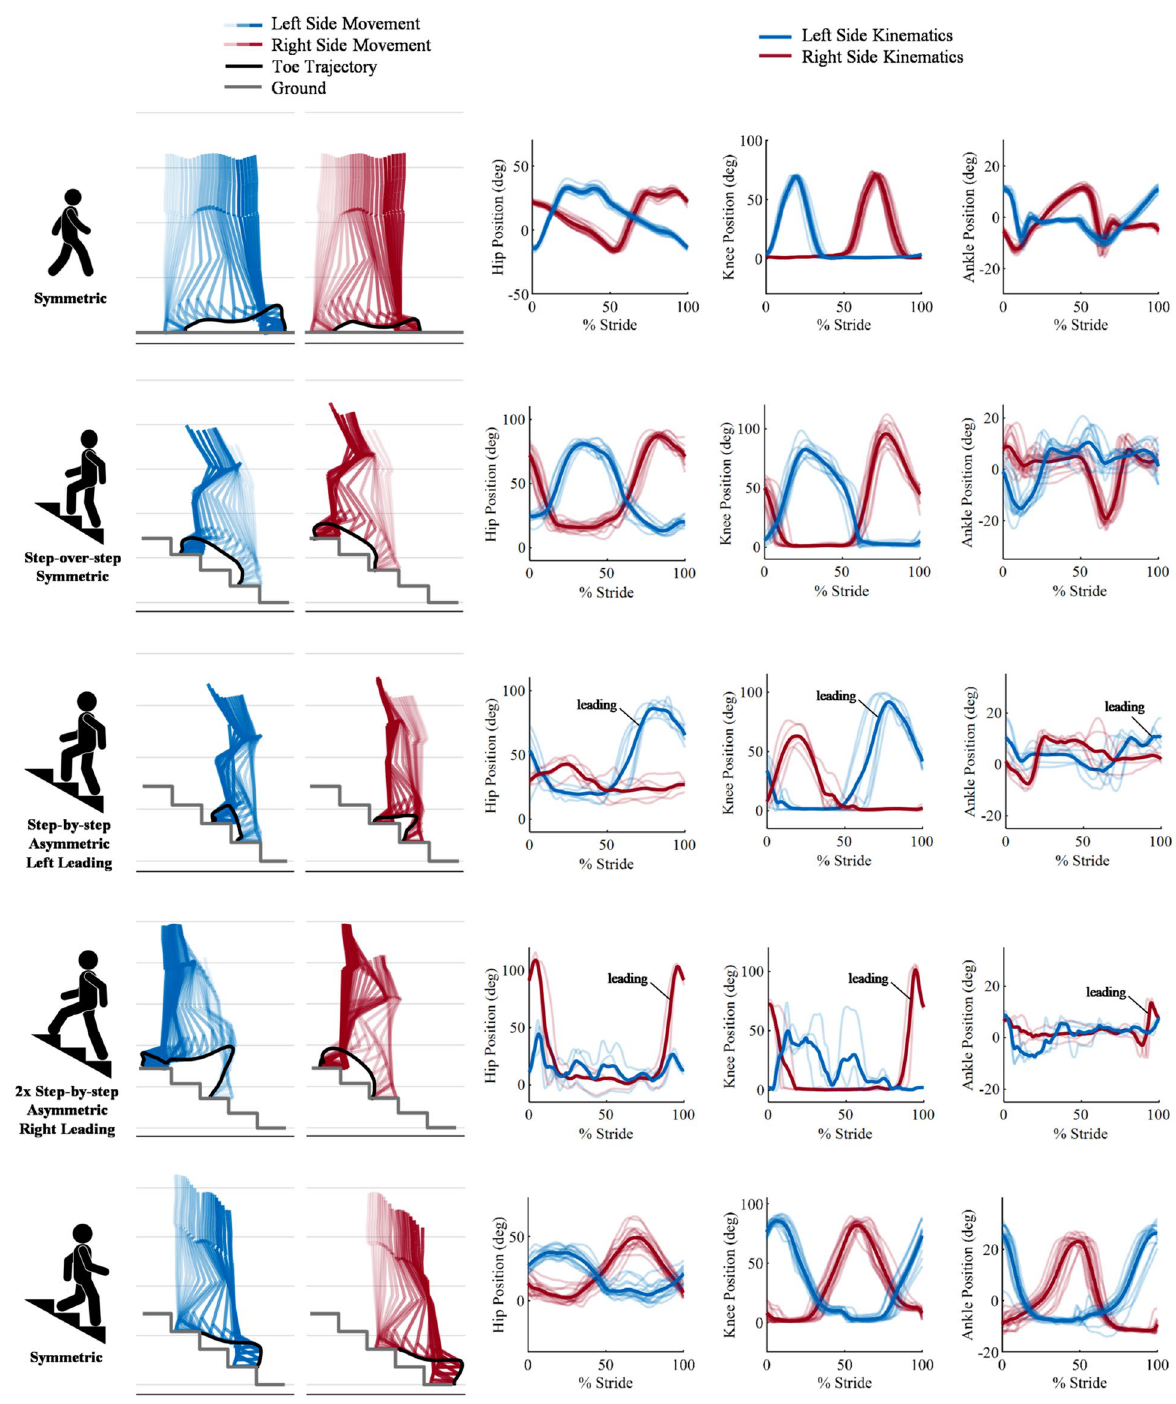
Figure 1. Cartesian space and joint kinematics for five ambulation activities of an individual with bilateral above-knee amputations. The cartesian space, sagittal plane movement of the participant wearing the powered prostheses are shown for the left side (blue) and the right side (red) with the lighter shade of color depicting the start of the movement and the darker shade of color depicting the end of the movement. The toe trajectory during the movement is represented by the solid black line. The level ground in walking or the stair configuration for stair ambulation is represented by the solid gray line. The hip, knee and ankle kinematic profiles (left to right) are shown with both the left side in blue and right side in red segmented for % Stride of the right leg for symmetric gait patterns, and % Stride of the leading leg for asymmetric gait patterns. All strides for each side are represented by a bolded average line. The activities represented are walking on level ground, stair ascent using symmetric step-over-step gait pattern, stair ascent using asymmetric step-by-step gait pattern with left side leading, stair ascent using asymmetric two-steps at a time step-by-step gait pattern with right side leading, and stair descent (top to